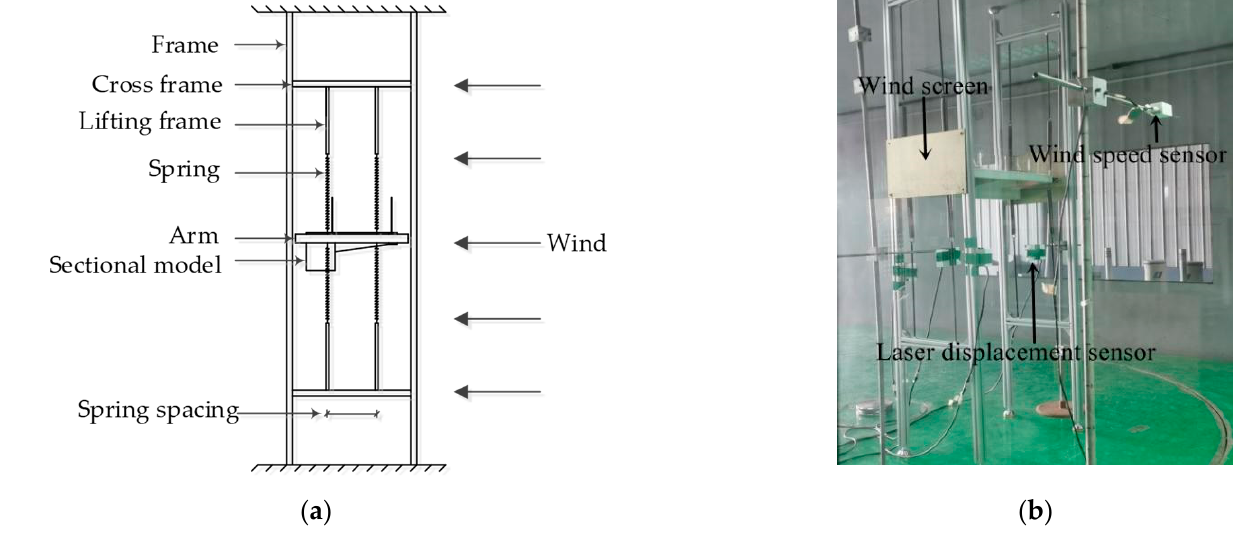
Figure 3. Diagram of sectional model vibration testing. ( a ) Diagram of vibration test system, ( b ) Picture of vibration test system.